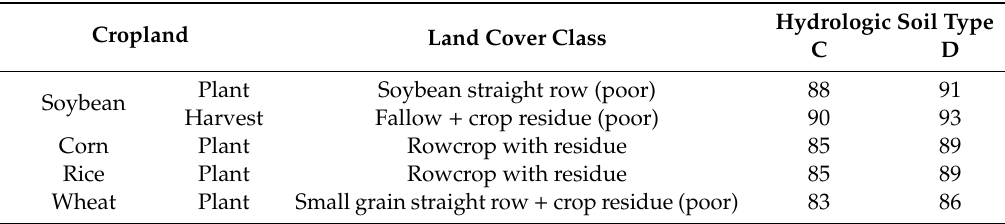
Table 3. Soil Conservation Service (SCS) curve numbers selected for runo ff estimation relative to cropland at the agricultural watershed. Source: USDA-SCS [47].